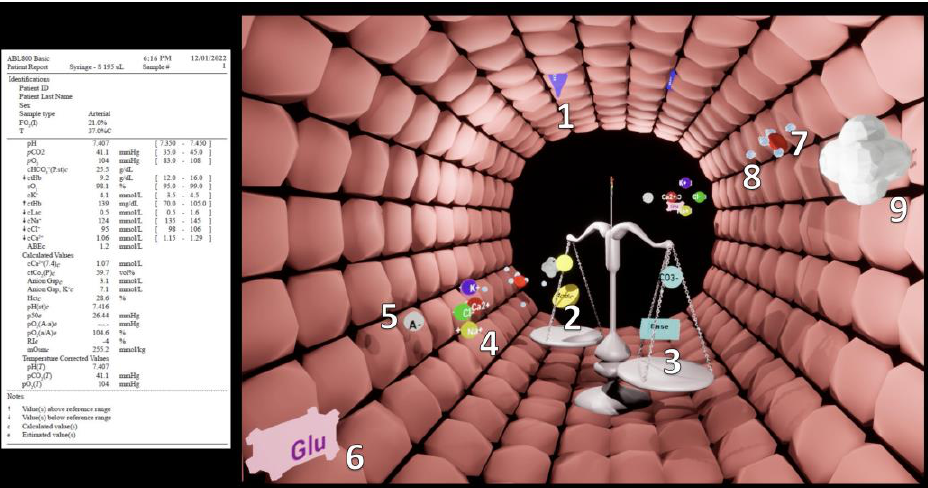
Figure 1. A standard arterial blood gas result printout on the left side and a VB visualisation on the right side. The blue water droplets diffusing through the vessel wall represent plasma osmolarity ( 1 ). The scale represents the acid–base balance. Acidic components include lactate and protons ( 2 ); alkaline components include bicarbonate and base excess ( 3 ). The electrolytes ( 4 ) sodium, potassium, chloride and calcium are illustrated in colour-coded form. The anion gap ( 5 ) is shown as a grey anion. Glucose ( 6 ) is illustrated in the form of pink sugar cubes. Haemoglobin ( 7 ) is represented by a red blood cell. It visualises together with oxygen molecules, oxygen saturation, and oxygen affinity, and can indicate the presence of too-high methaemoglobin or carboxyhaemoglobin concentrations. The unbound oxygen molecules represent the oxygen partial pressure ( 8 ). Carbon dioxide partial pressure ( 9 ) is shown in the form of a grey cloud.